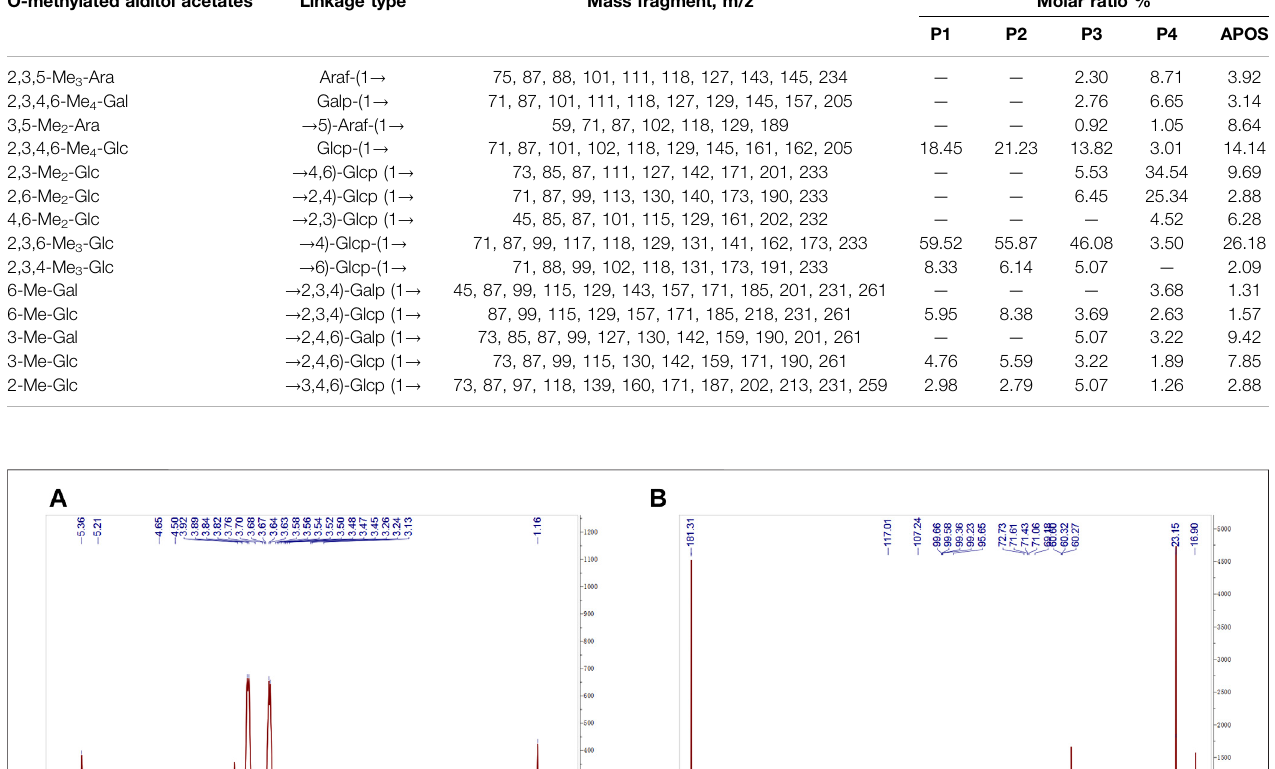
TABLE 2 | Results of methylation analysis of different saccharide components. O-methylated alditol acetates